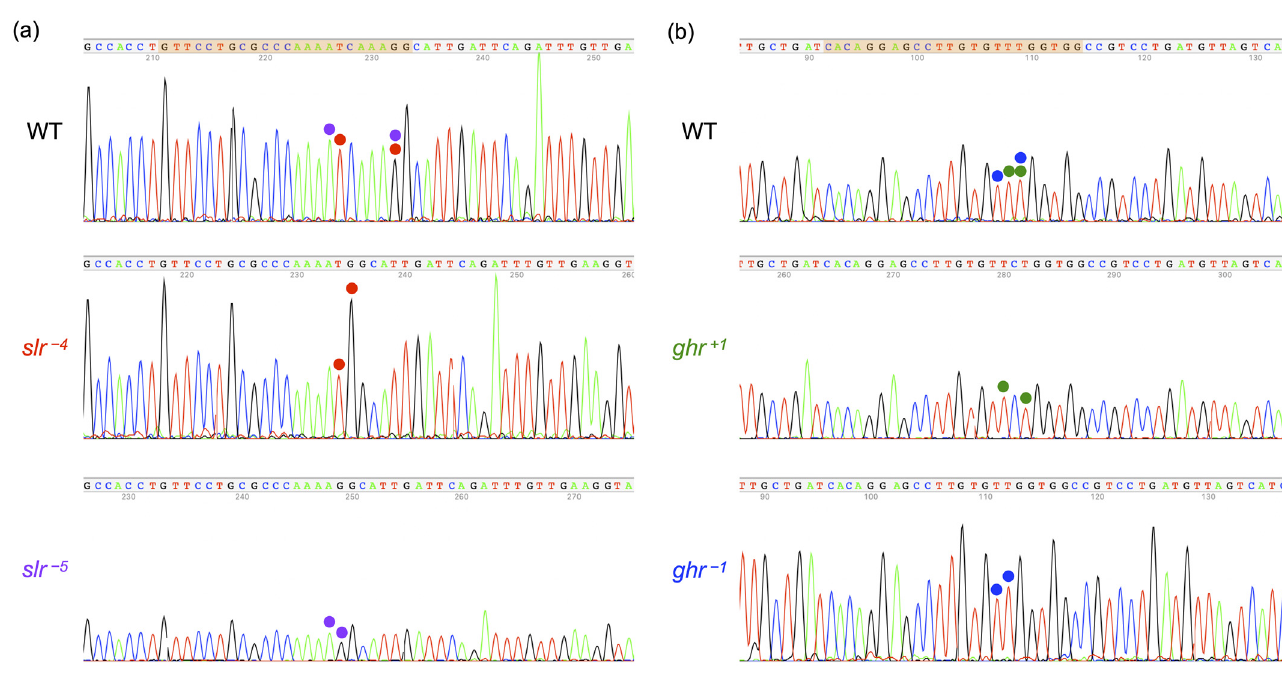
Figure 3. Electropherograms of target sequences and frameshift mutations in SLR and GHR . The target sequences (highlighted in orange) for the wild-type (WT) fish are shown at the top for SLR ( a ) and GHR ( b ). Corresponding nucleotides in the WT and mutant fish are marked by colored circles. Four bases (CAAA) or five bases (TCAAA) are deleted in slr − 4 and slr − 5 , respectively. One base (C or T) is inserted or deleted in ghr +1 or ghr − 1 , respectively.